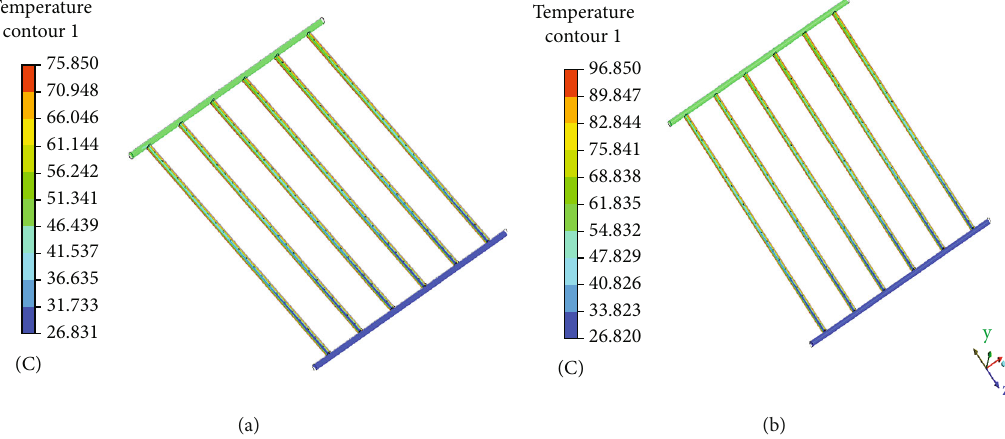
Figure 5: (a) Analysis of low temperature. (b) Analysis of high